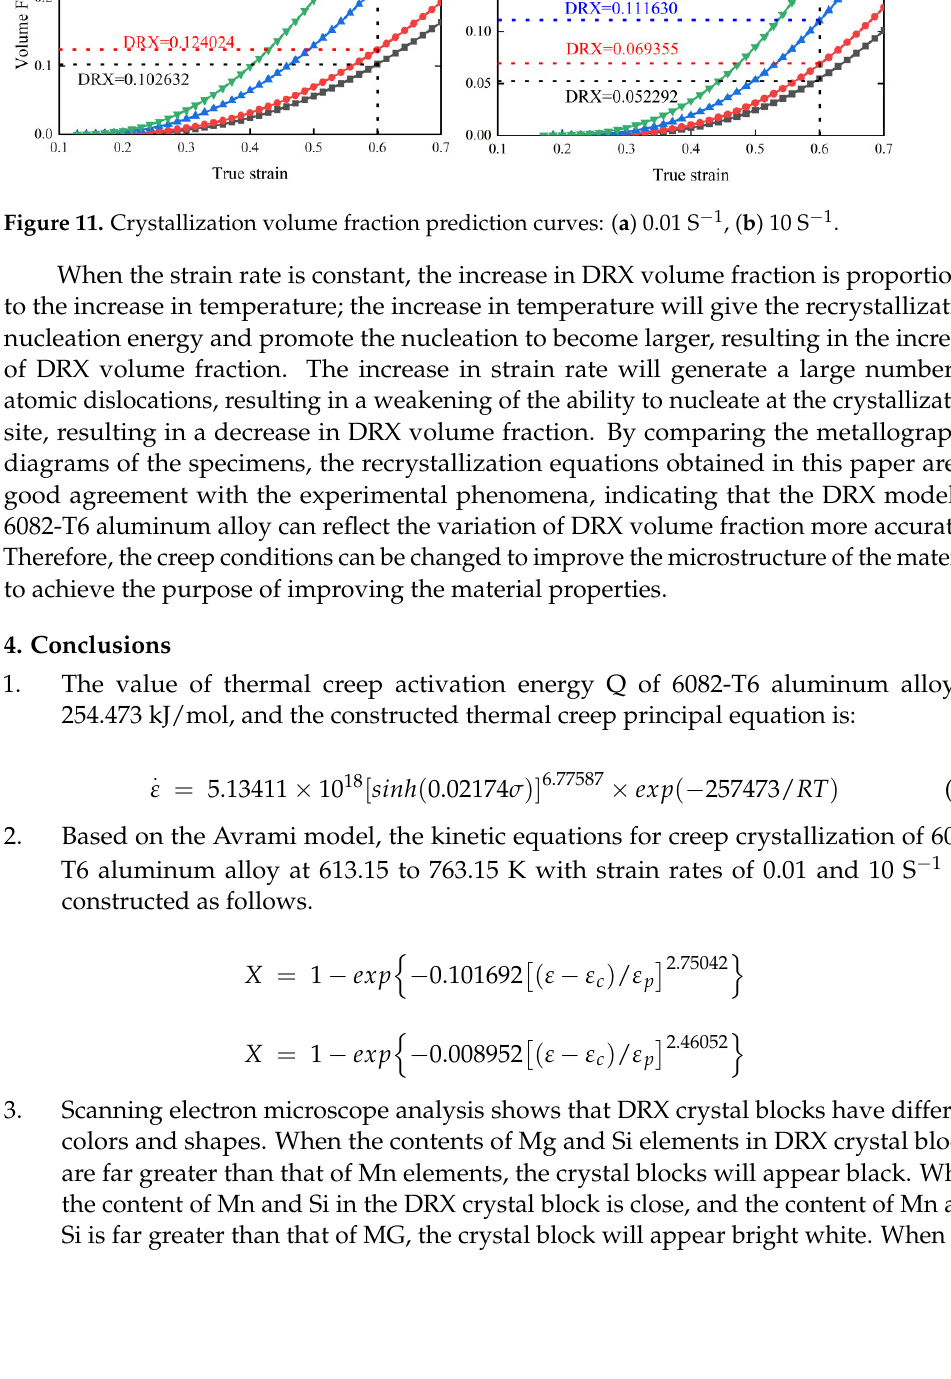
Figure 10.  [1/(1 − )] − [( −   )/  ] fit plots: ( a ) 0.01 S −1 , ( b ) 10 S −1.